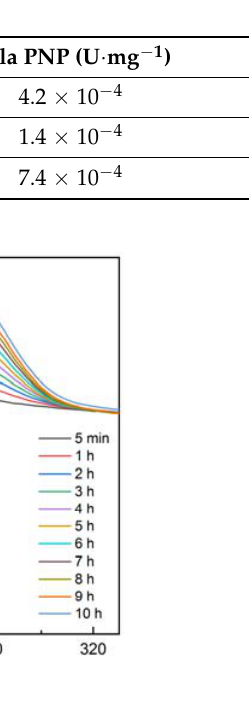
Figure 12. Differential absorbance spectra for the 6Ala PNP mutant PNP (0.11 mg/mL) incubated with 200 μ M inosine in 50 mM phosphate buffer pH 7.0 at 25 °C. Spectra (in 1 cm path length cuvette) were measured after 5 min from the start of the reaction (black line) and, next, every hour.